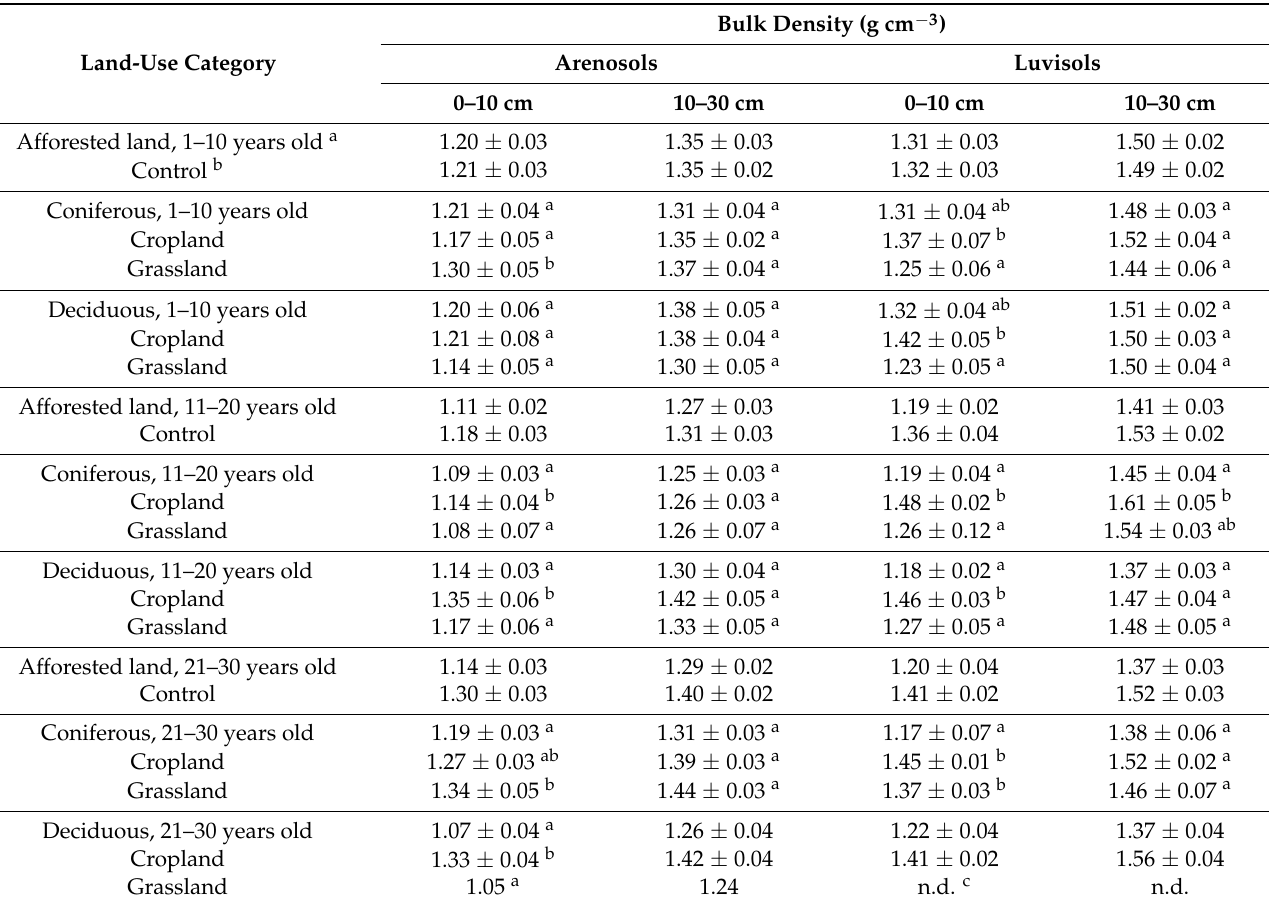
Table 3. Mean bulk density (g cm − 3 ) of fine (<2 mm) soil in mineral topsoil of Arenosols and Luvisols [47]. Different letters a and b indicate significant differences between the means of different land uses within one topsoil layer of each Arenosol and Luvisol at p <